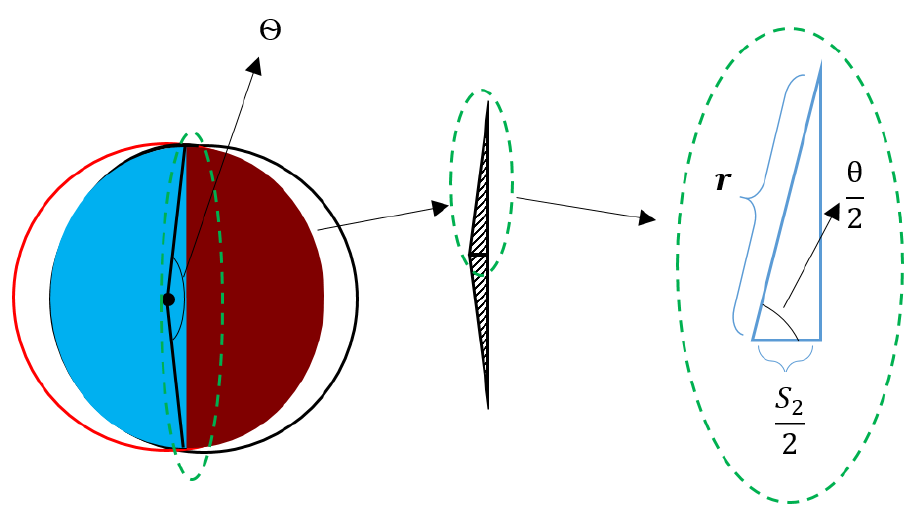
Figure 5. Schematic view of the circle and its relationship with the arc segment area.